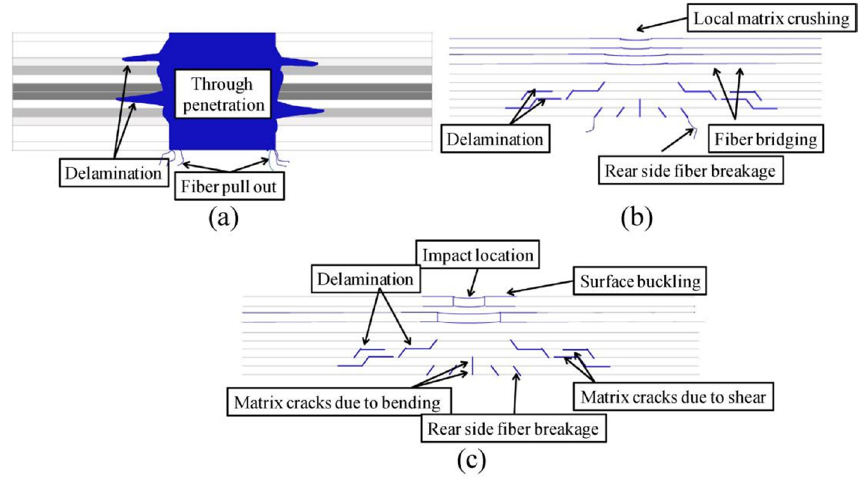
Figure 18: Schematic showing di ff erent damage mechanisms due to impact load: ( a ) high energy, ( b ) medium energy, and ( c ) low energy [ 97 ] .